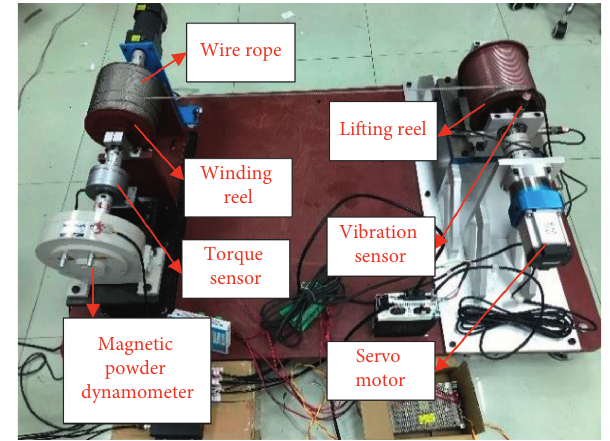
Figure 11: The fault simulation test bench.